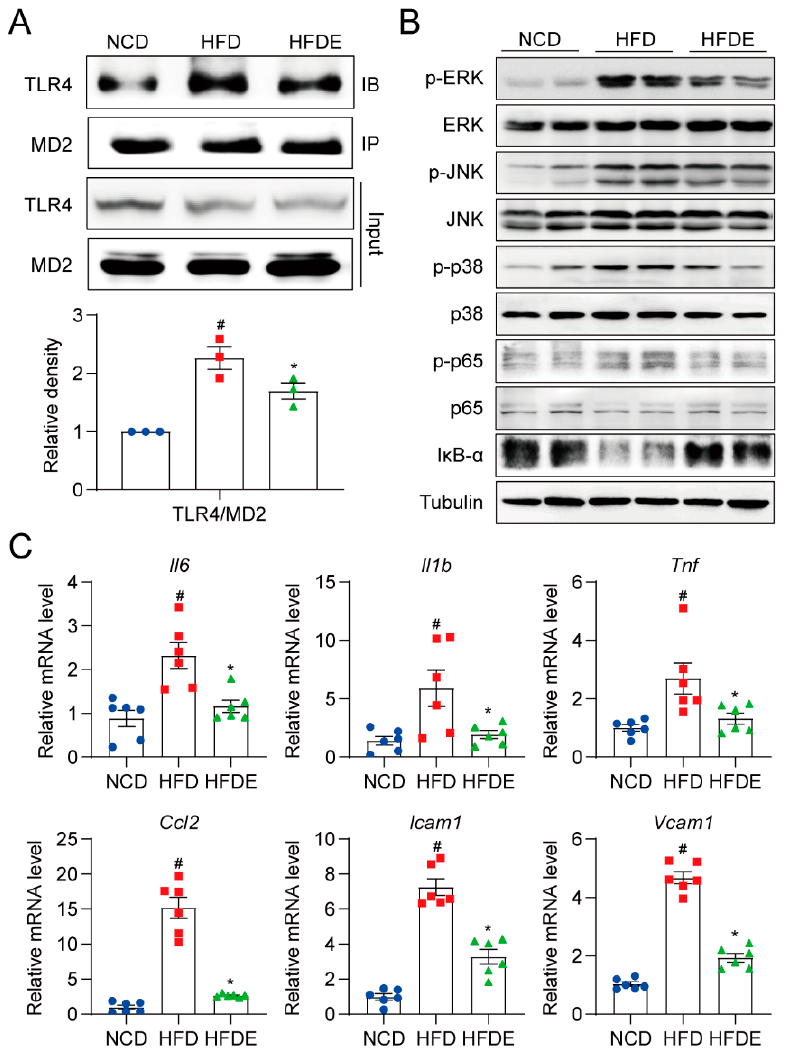
Figure 4. Exercise blocks MD2-TLR4 pathway activation in mouse livers. ( A ) MD2-TLR4 complex formation levels in mouse liver tissues detected by co-immunoprecipitation. ( B ) Protein levels of MAPK pathway and NF- κ B pathway components, including p-ERK, p-JNK, p-p38, p-p65, and I κ B- α . The corresponding unphosphorylated proteins and tubulin were used as the loading controls.